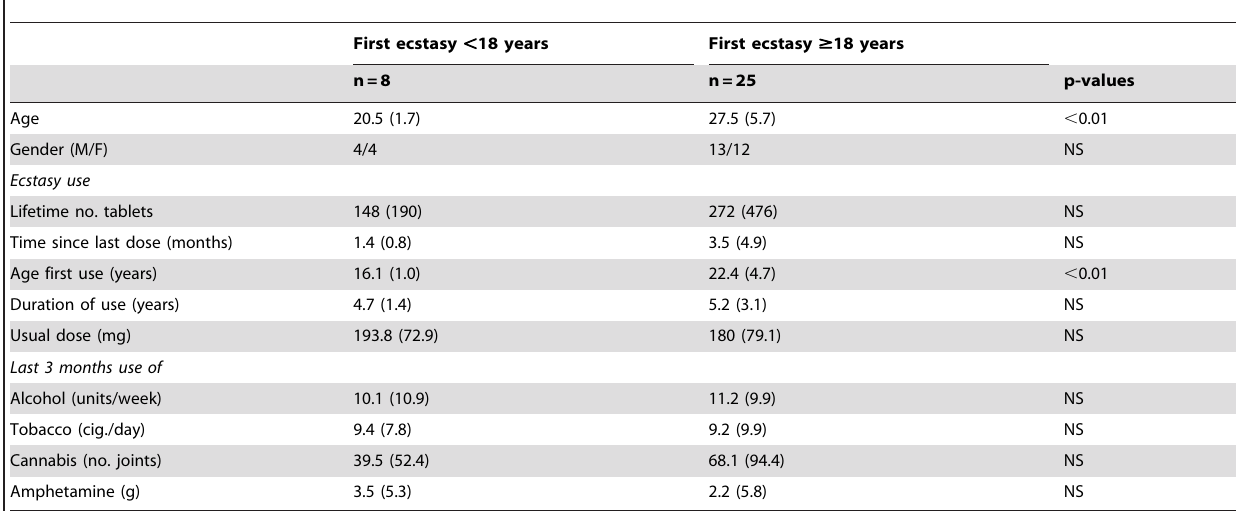
Table 1. Demographics, characteristics of MDMA use and exposure to other recreational drugs.